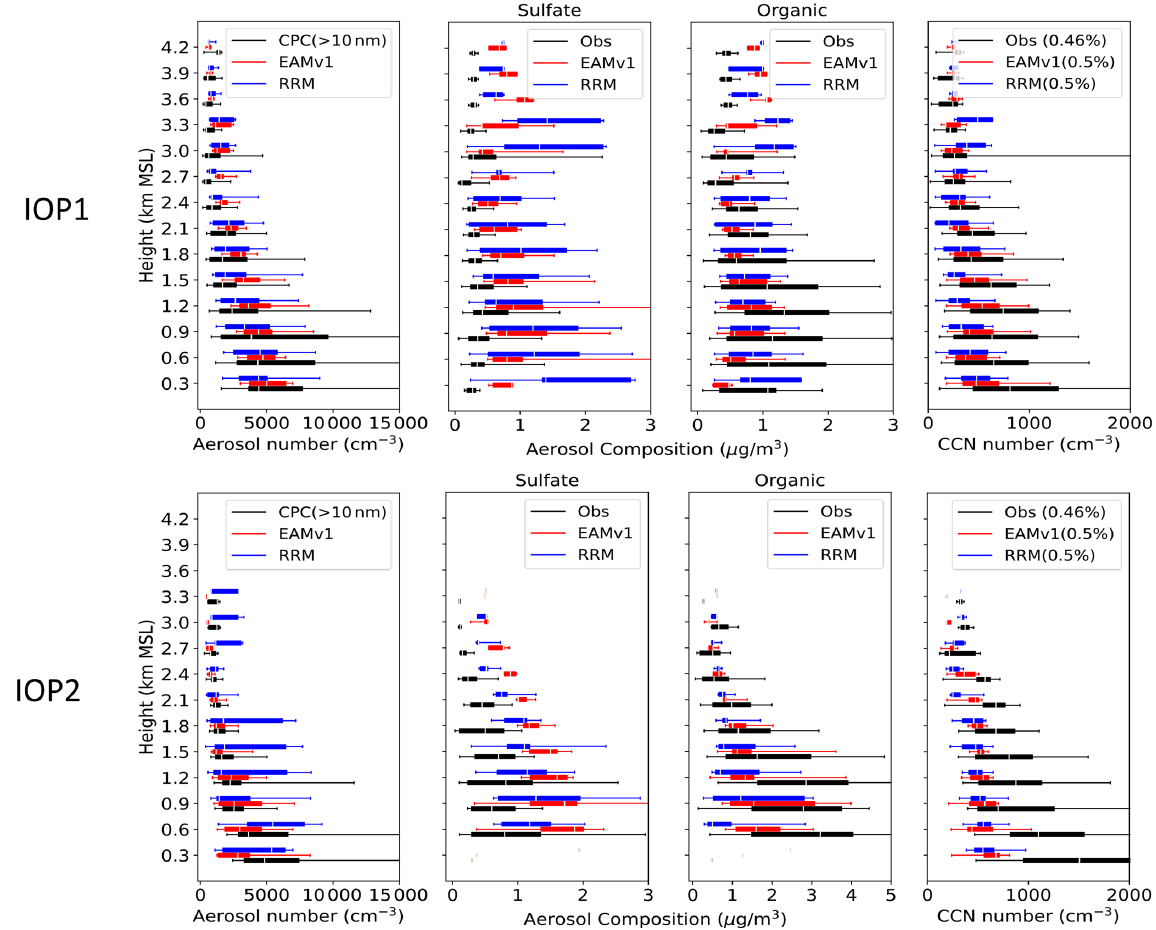
Figure 7. Vertical profiles of (from left to right) aerosol number concentration, mass concentration of sulfate, mass concentration of total organic matter, and CCN number concentration under the supersaturation in the parentheses for HI-SCALE (top) IOP1 and (bottom) IOP2. The percentile box represents the 25th and 75th percentiles, and the bar represents the 5th and 95th percentiles.